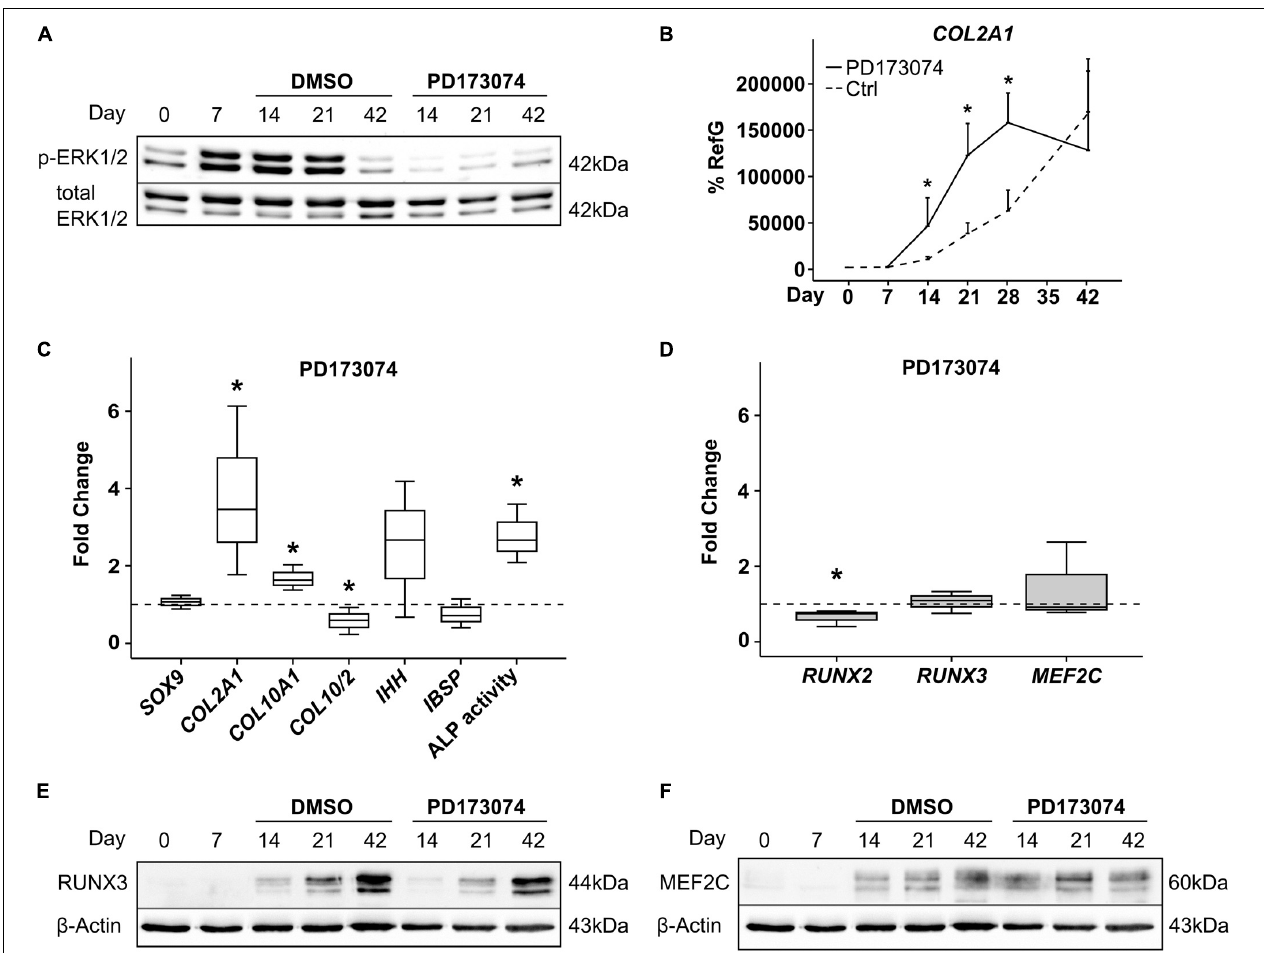
FIGURE 6 | Effects of FGF-receptor inhibition on RUNX2, RUNX3, and MEF2C. MPC pellets were subjected to chondrogenic induction for 6 weeks and treated with 250 nM of the FGFR-Inhibitor PD173074 or with the corresponding amount of DMSO from day 7 onward. Protein levels of pERK1/2 and total ERK1/2 as reference were detected by Western blot (A) . Shown is one representative of three experiments. (B) Gene expression of COL2A1 was determined during 42 days of chondrogenesis with PD173074 (black line) or DMSO control (dashed line) ( n = 3 donors), (C,D) expression of indicated genes was determined by qPCR at day 21 of chondrogenesis, and levels were referred to reference genes HNRPH1 and CPSF6 . ALP activity was quantified in culture supernatants (C) . Expression levels of indicated genes and ALP activity are referred to DMSO cultures (dashed lines). Box plots were generated as described in Figure 1 . *, p ≤ 0.05, Mann–Whitney U test compared to control. (E,F) RUNX3 and MEF2C protein levels were determined in samples with DMSO or PD173074 at indicated timepoints, β -actin levels were determined as internal reference. One representative of three experiments is